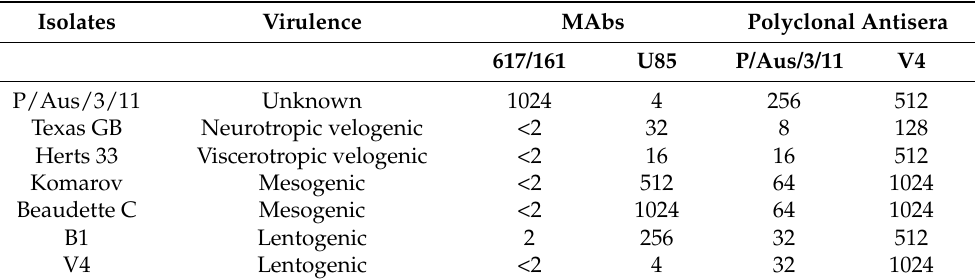
Table 2. Reactivity of monoclonal antibodies and polyclonal antisera with representative avian paramyxovirus serotype-1 (APMV-1) isolates by